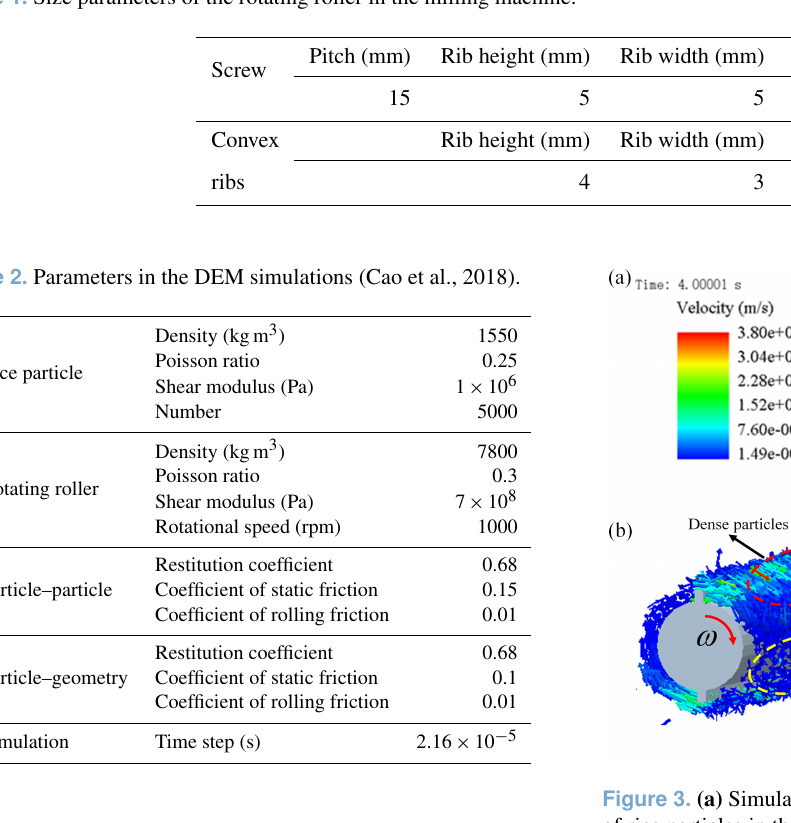
Table 1. Size parameters of the rotating roller in the milling machine.